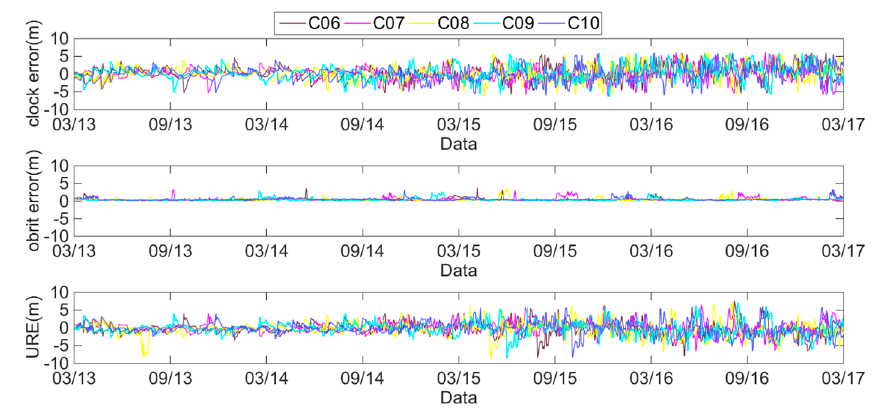
Figure 2. Errors of GEO satellites from 1 March 2013 to 1 March 2017.